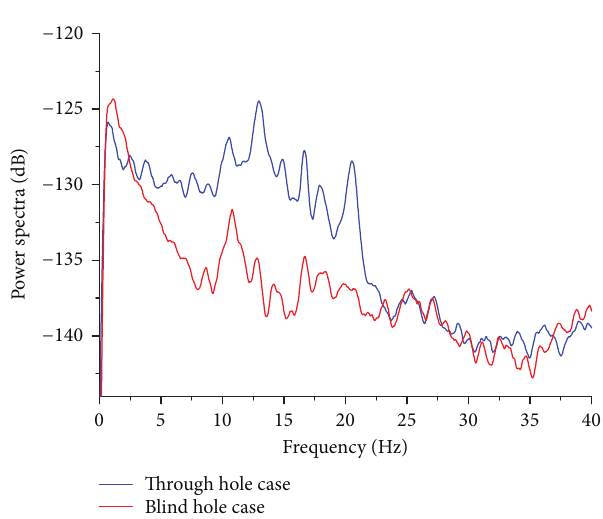
Figure 13: Displacement power spectral density of the fuel rod in two cases at 𝑞 V = 3.62 m 3 /